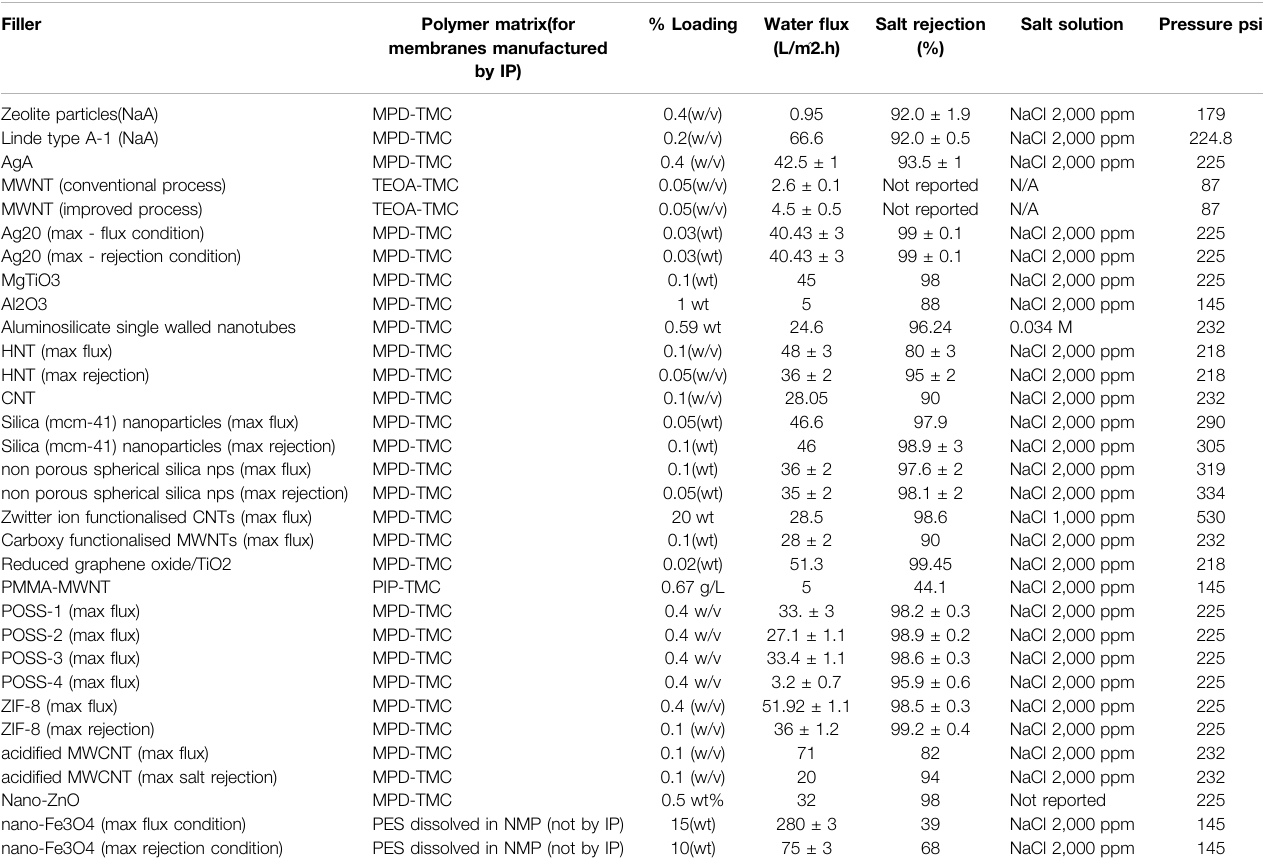
TABLE 3 | Water fl uxand NaCl rejection at givenloadingofnanoparticle fi llersin TFNmembranes (Fathizadehet al., 2011;Daraei et al.,2012; Huang et al.,2013a; Kim E.S. et al., 2013; Alam et al., 2013; Baroña et al., 2013; Huang et al., 2013b; Chan et al., 2013; Shen et al., 2013; Zhao et al., 2014; Ghanbari et al., 2015; Safarpour et al.,